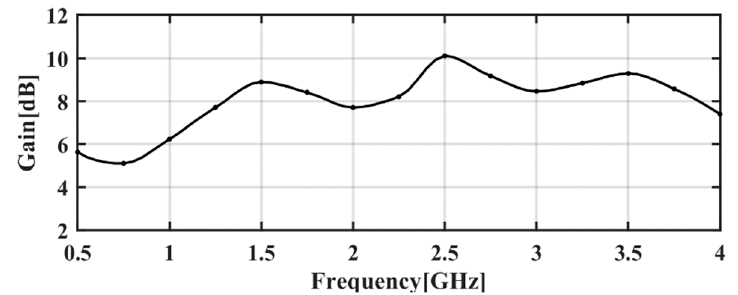
Figure 10. Total gain as a function of frequency of the designed Vivaldi antenna.